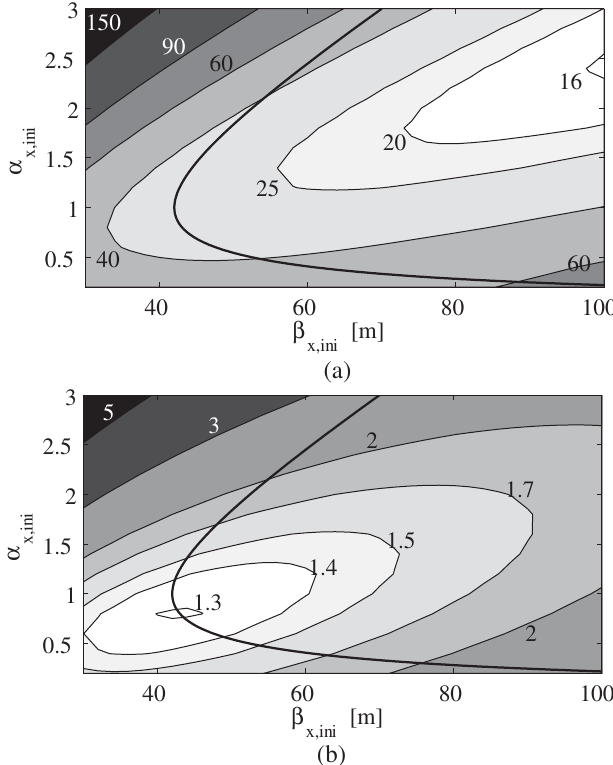
FIG. 4. Contour plots of CSR (a) and ISR (b) emittance growth versus initial beta function and alpha. The thick black lines mark the initial values resulting in symmetric beta functions. Values on the left side of these lines result in a waist of the beta function closer to the front of the chicane, values on the right side result in a waist closer to the